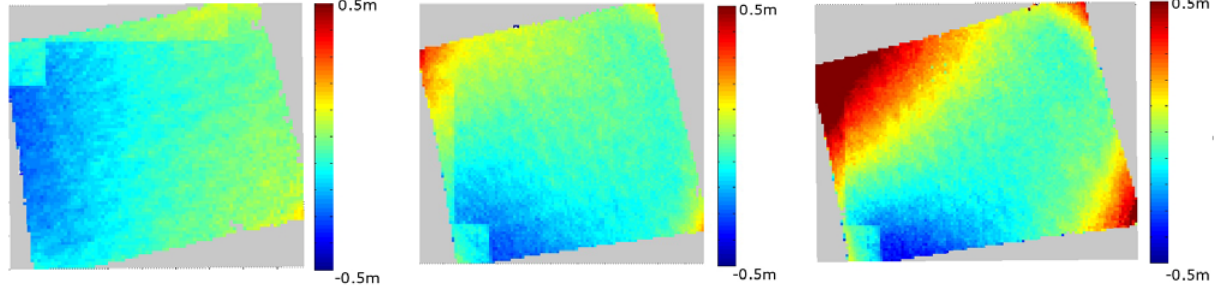
Figure 12. Differences of DSMs calculated from stereo models with 60% ( left ), 80% ( center ) and 90% ( right ) overlaps to the reference